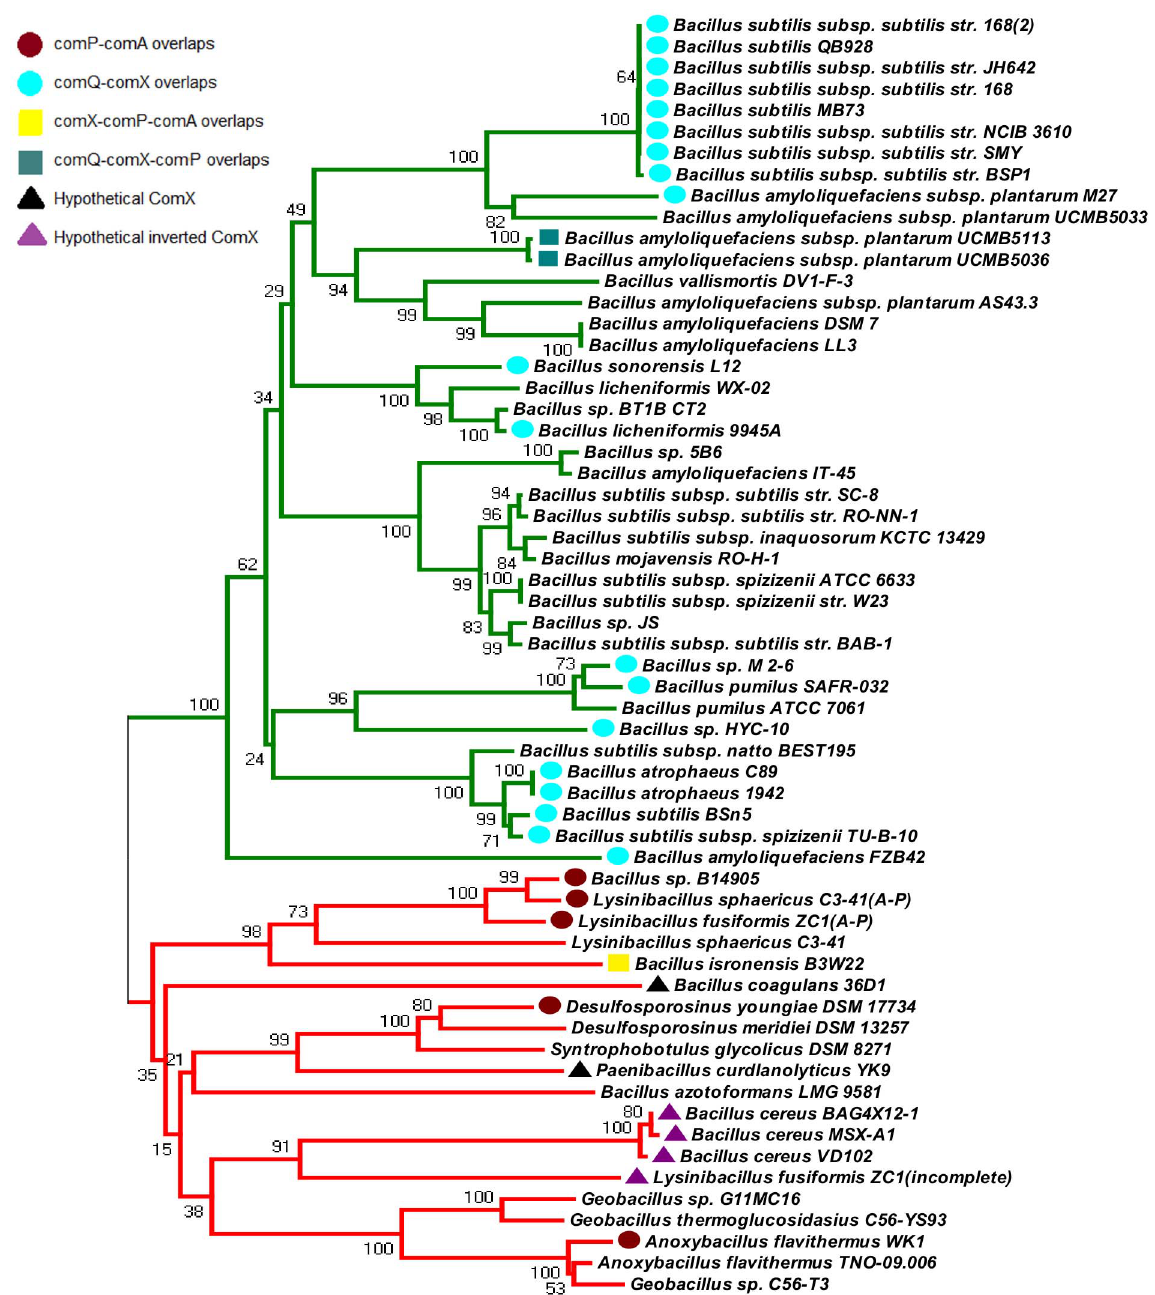
Figure 2. A similarity cladogram of ComQ sequences. The larger clade (green) that we termed ‘‘ B. subtilis -like’’ contains the B. subtilis and a few other species from the Bacillus genus that are closely related. The other, visibly more varied one (red) contains non- B. subtilis sequences. The overlaps are indicated as highlighted bullets before each species.